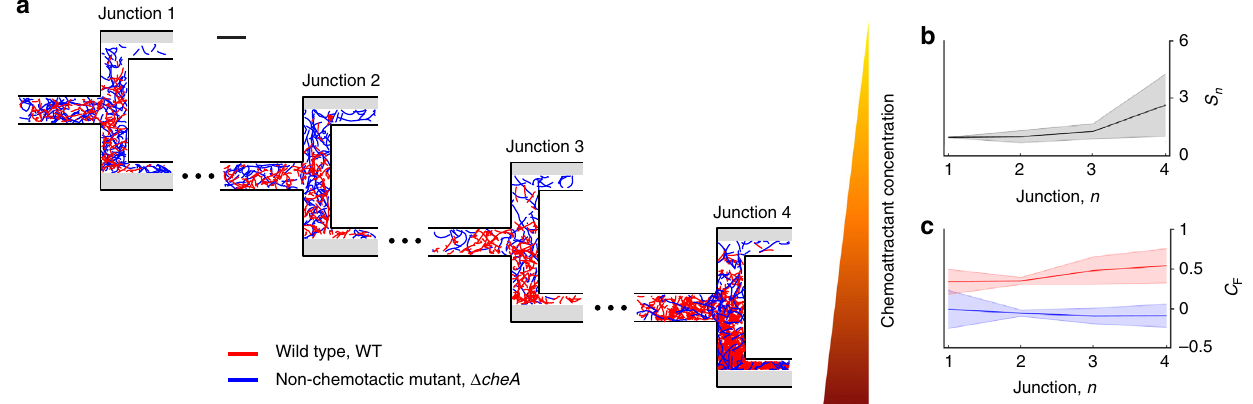
Fig. 2 Demonstration of cell sorting in the micro fl uidic T-maze using marine bacteria. a The micro fl uidic T-maze sorts Marinobacter adhaerens wild type (red) from a nonchemotactic mutant ( Δ cheA ; blue) in an initial 1:1 mixture as cells migrate through the device. Chemoattractant concentration (liquid 2216 medium) increases from top to bottom in the fi gure (yellow – red color scale). Diagrams of the junctions show measured cell trajectories. The scale bar shown in the fi gure is 200 μ m. b The sorting index, S n , the ratio of WT to mutant cells found at each junction. c The choice factor, C F , measuring the tendency of cells to swim up the gradient at each junction (red and blue for wild type and mutant, respectively). Curves in ( b ) and ( c ) show mean ± s.d. over three